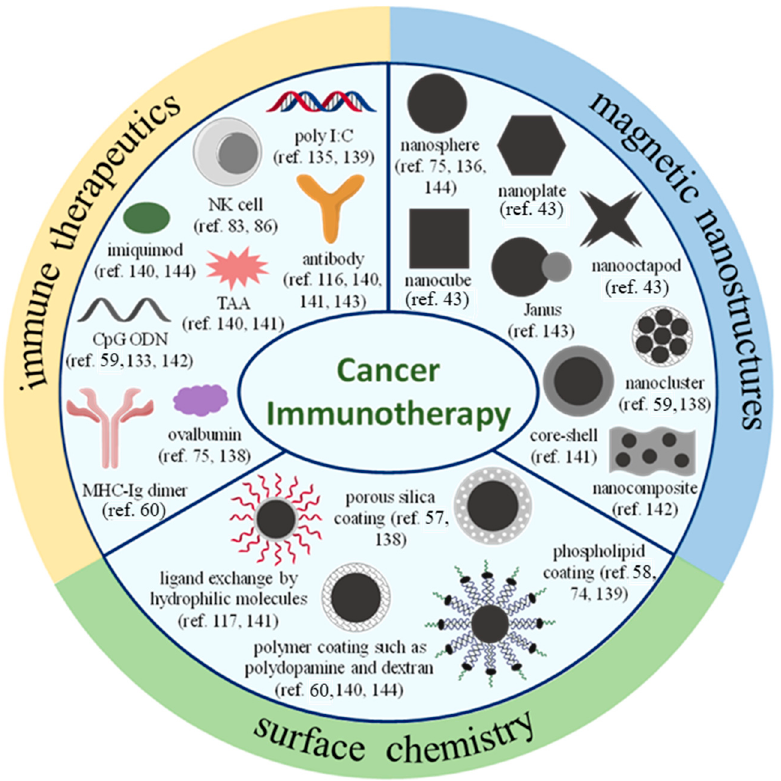
Figure 3. A schematic diagram summarizing the design and synthesis of magnetic nanostructure- based nanosystems for cancer immunotherapy.